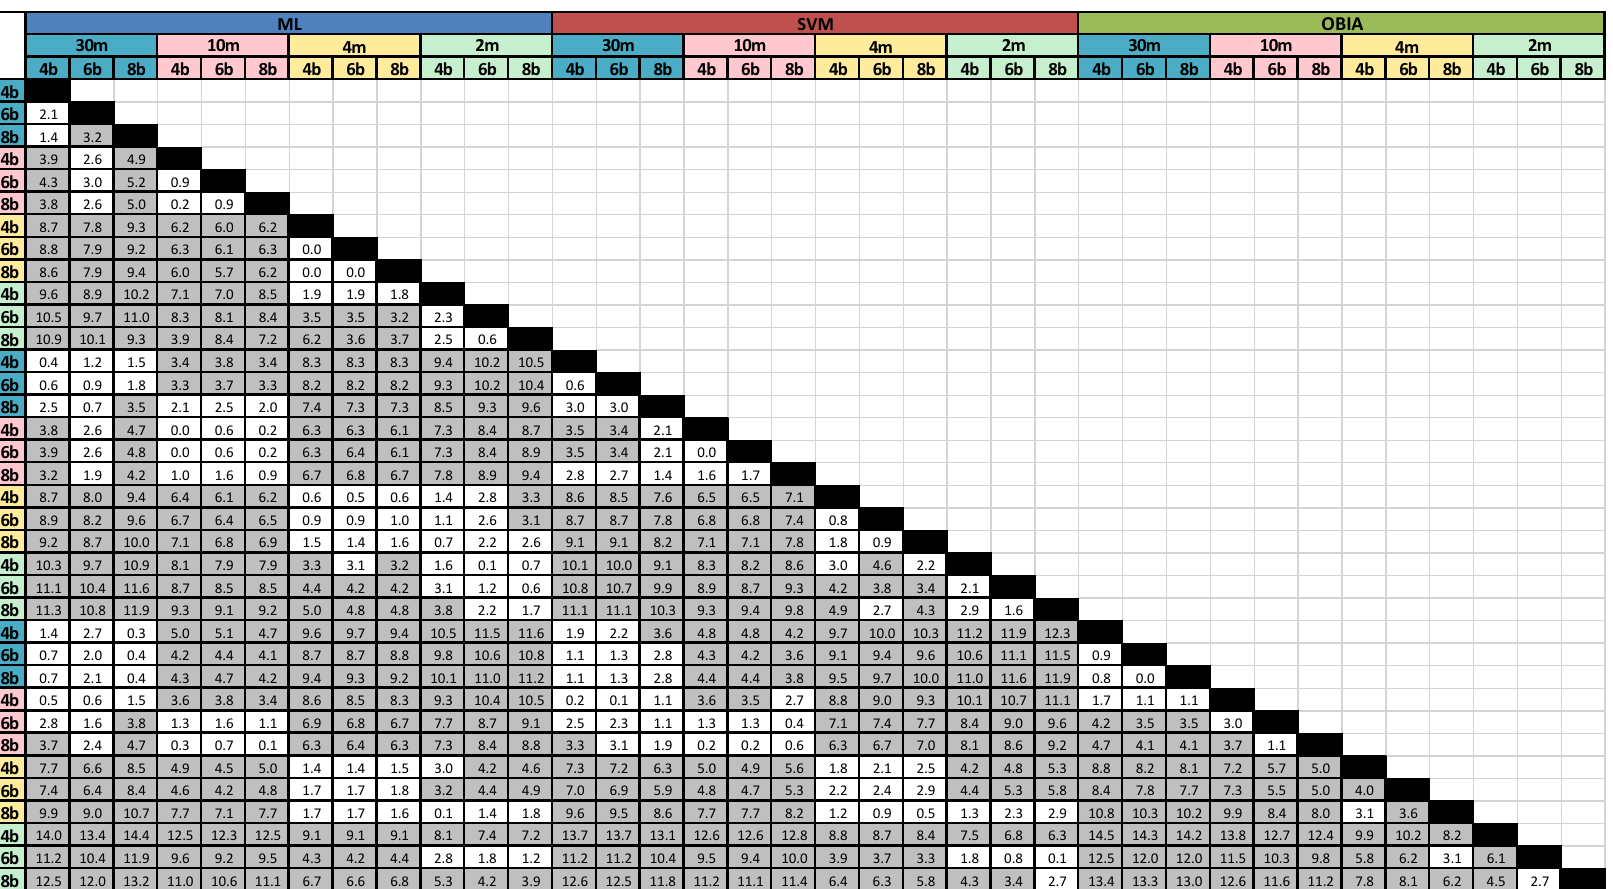
Figure 7. Matrix of McNemar test z values showing the statistical significance of differences between all classification pairs (ML = maximum likelihood, SVM = support vector machine, OBIA = object-based image analysis; 30 m, 10 m, 4 m and 2 m refer to spatial resolution; 4b, 6b and 8b refer to the number of spectral bands; z values ≥ 3.2 (highlighted grey) are statistically significant at the 99% confidence level).